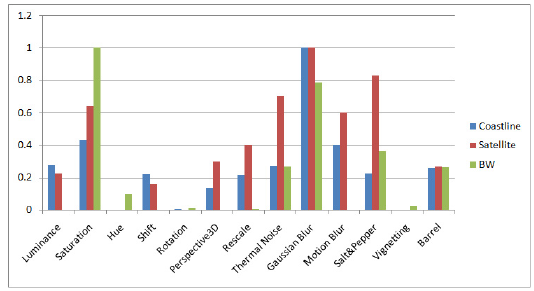
Figure 11. Distortion - Mosaicing SSIM MSE Response Normalized